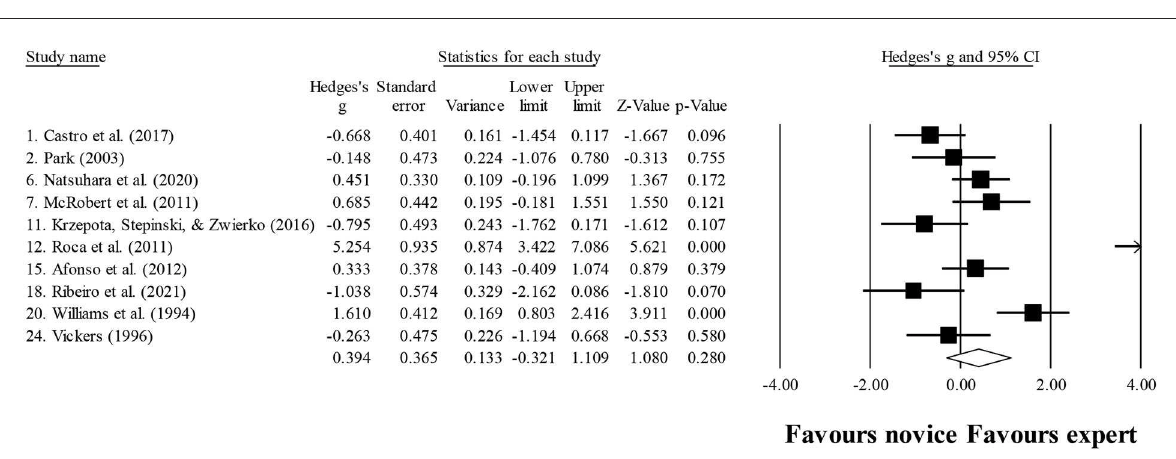
FIGURE6 Number of fixations: greater (although not significant) number of fixations was noted for expert athletes compared to novice athletes. Black squares: individual studies. Its size represents their relative weights. White rhomboid: summary value.